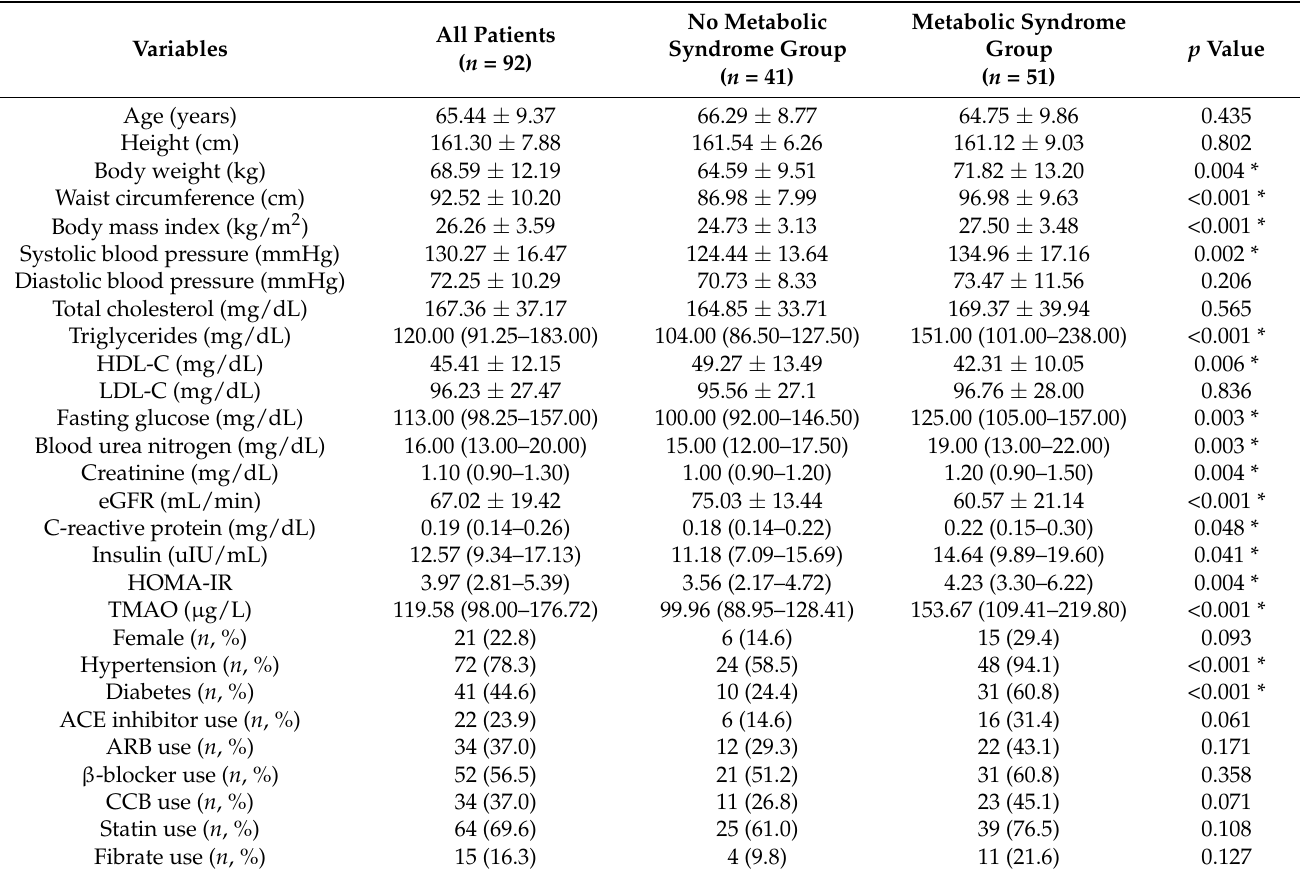
Table 1. Demographic and clinical characteristics of the study